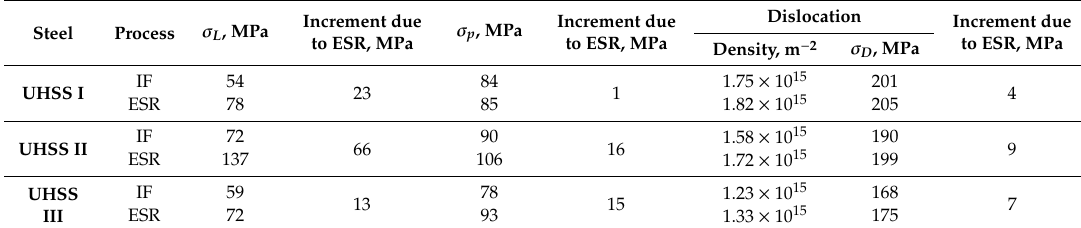
Table 7. Contributions to yield strength.